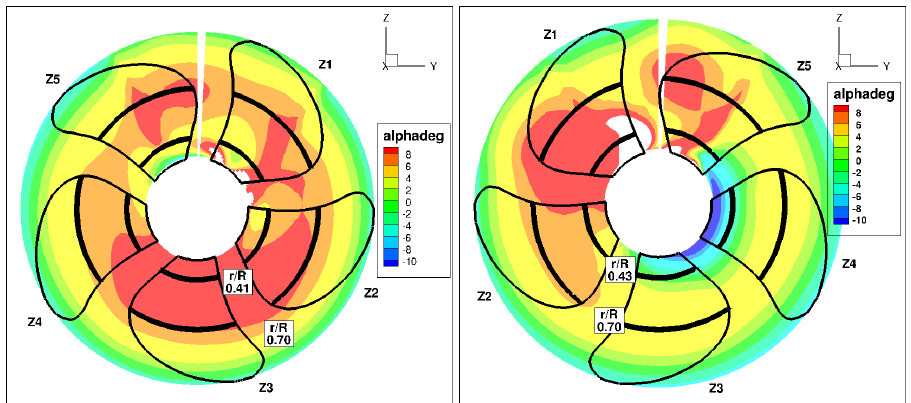
Figure 17. Propulsive performances of the model hull in steady drift motion at 8.4 ◦ , J = 1.12: incidence angle of attack at the starboard actuator disc inlet section. ( Left ): portside propeller. ( Right ): starboard propeller.